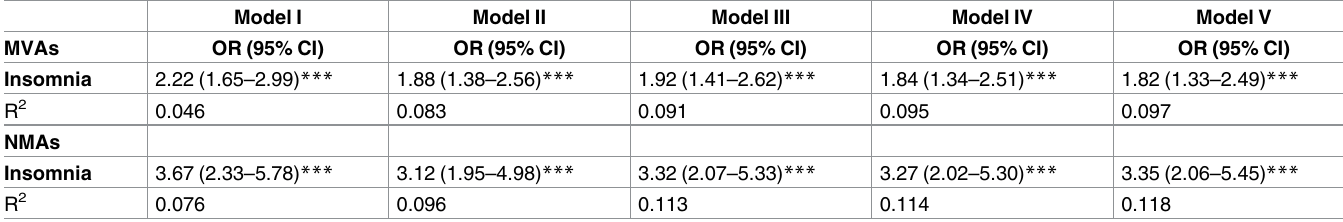
Table 2. Multivariate association between sleep variables, MVAs and